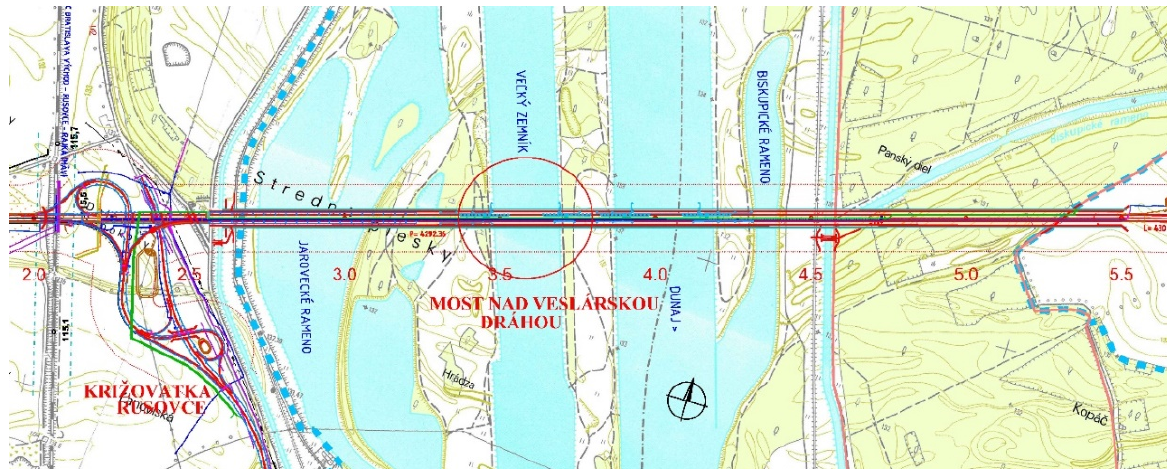
Figure 1. Bridges crossing the Danube and its branches.